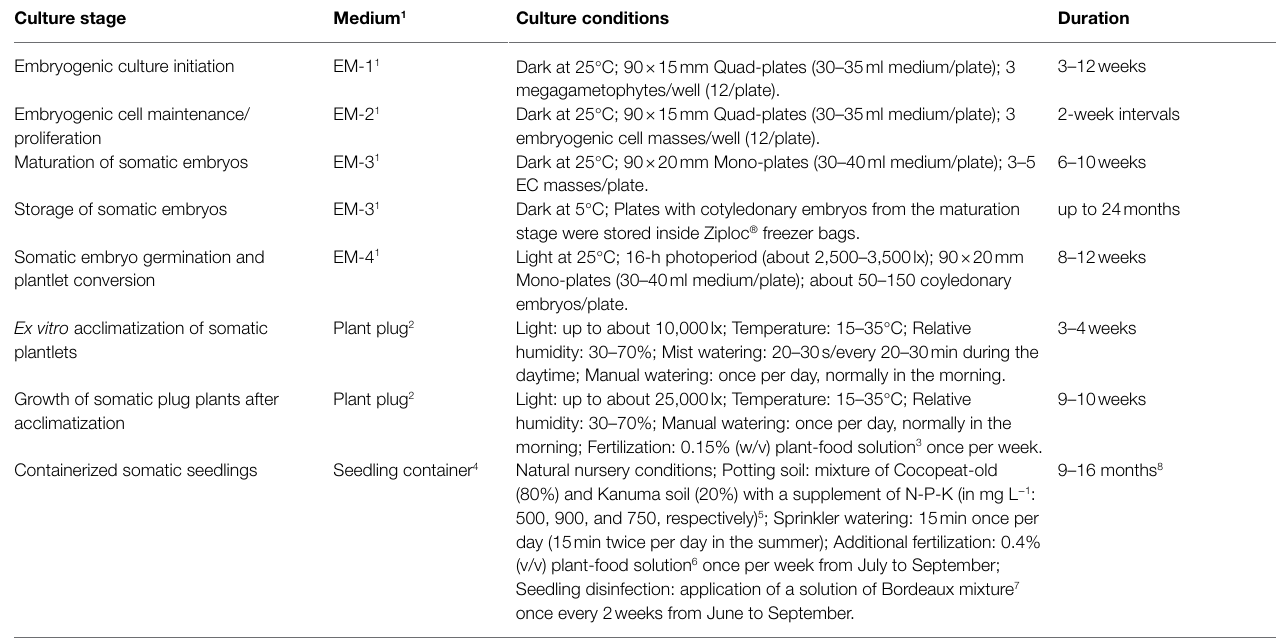
TABLE 2 | Medium, culture condition, and culture duration for each stage in the propagation of pollen-free sugi ( C. japonica ) plants via somatic